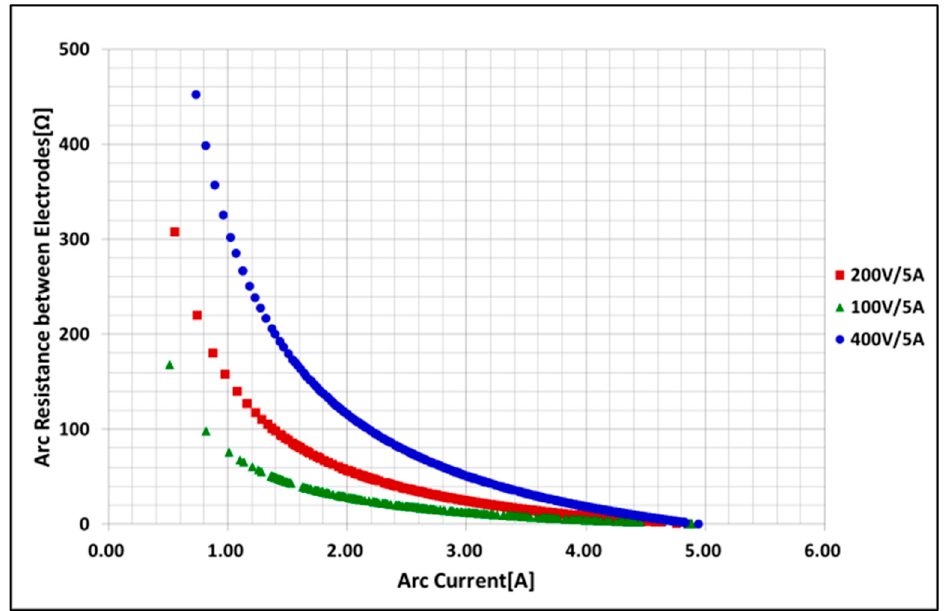
Figure 13. Arc resistance and arc current experimental results (source voltage change).